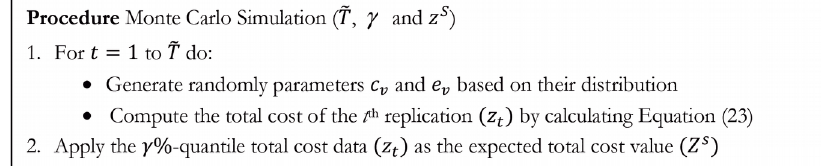
Figure 4. The procedure of Monte Carlo